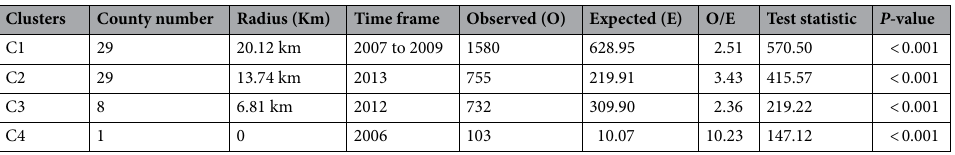
Table 1. Space–time clusters of hemorrhagic disease in wild white-tailed deer in Illinois between 2006 and 2019. The retrospective spatial analysis, scanning for clusters with high rates, uses a space–time permutation model with the SaTScan software; Spatial unit: centroid of a county; Temporal unit: year; Circular scanning window size of 50% of population at risk, and 50% of study